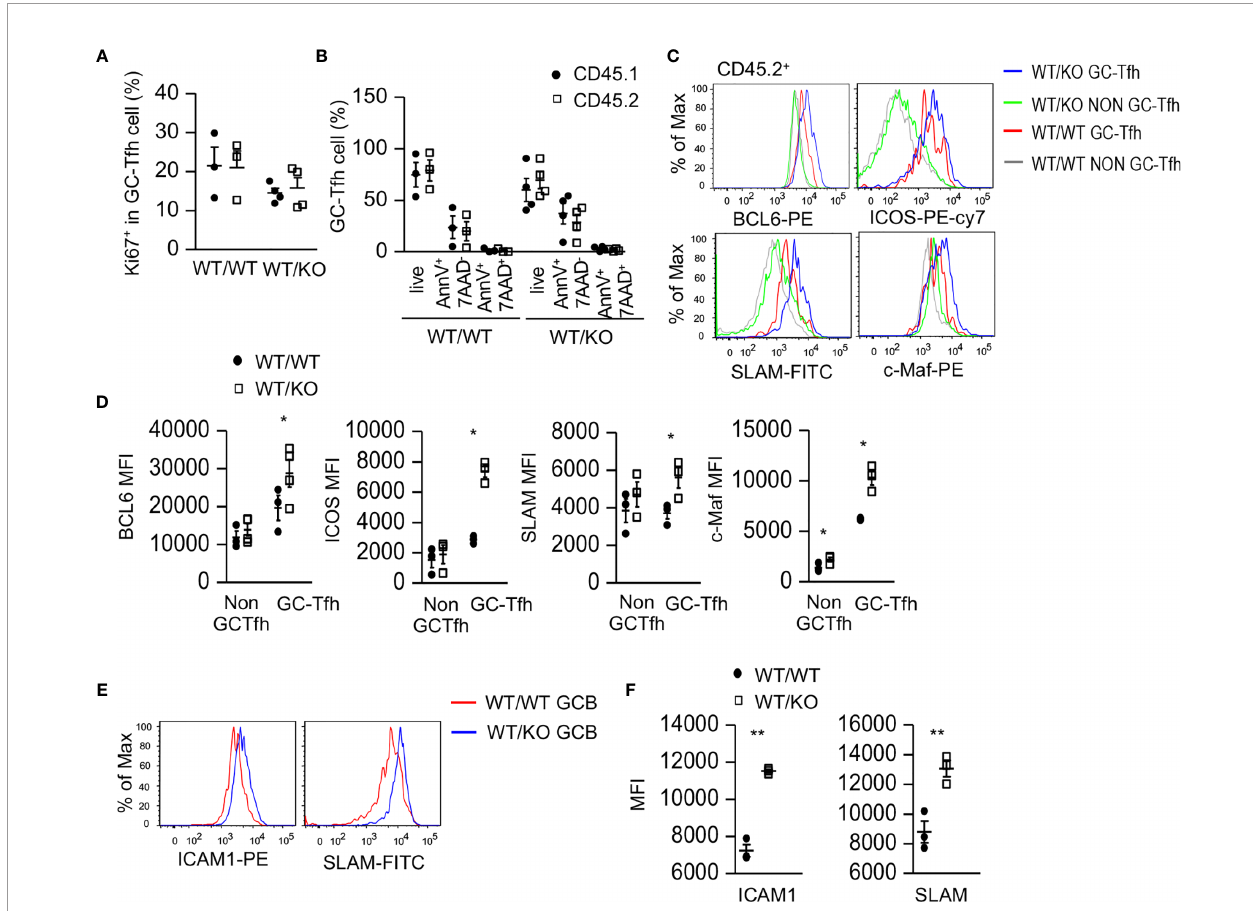
FIGURE 3 | Increased expression of Tfh cell promoting molecules in Tsc1-de fi cient GC-Tfh cells. Splenocytes in the mixed BM chimeric mice shown in Figure 2 were analyzed. (A) Scatterplots represent mean ± SEM of Ki67 + cells in CD45.1 + CD45.2 - and CD45.1 - CD45.2 + GC-Tfh cells. (B) Scatterplot represents mean ± SEM of survival and death rates of Tfh cells. (C) Overlaid histograms show Bcl6, cMaf, ICOS, and SLAM levels in GC-Tfh and non-GC-Tfh cells. (D) Scatterplots represent mean ± SEM of MFI of Bcl6, cMaf, ICOS, and SLAM in GC-Tfh and non-GC-Tfh cells. (E) Overlaid histograms show ICAM1 and SLAM levels in GC-B cells. (F) Scatterplots represent mean ± SEM of MFI of ICAM1 and SLAM levels in GC-B cells. Data represent or are pooled from three experiments. * p < 0.05; ** p < 0.01 determined by an unpaired two-tailed Student t